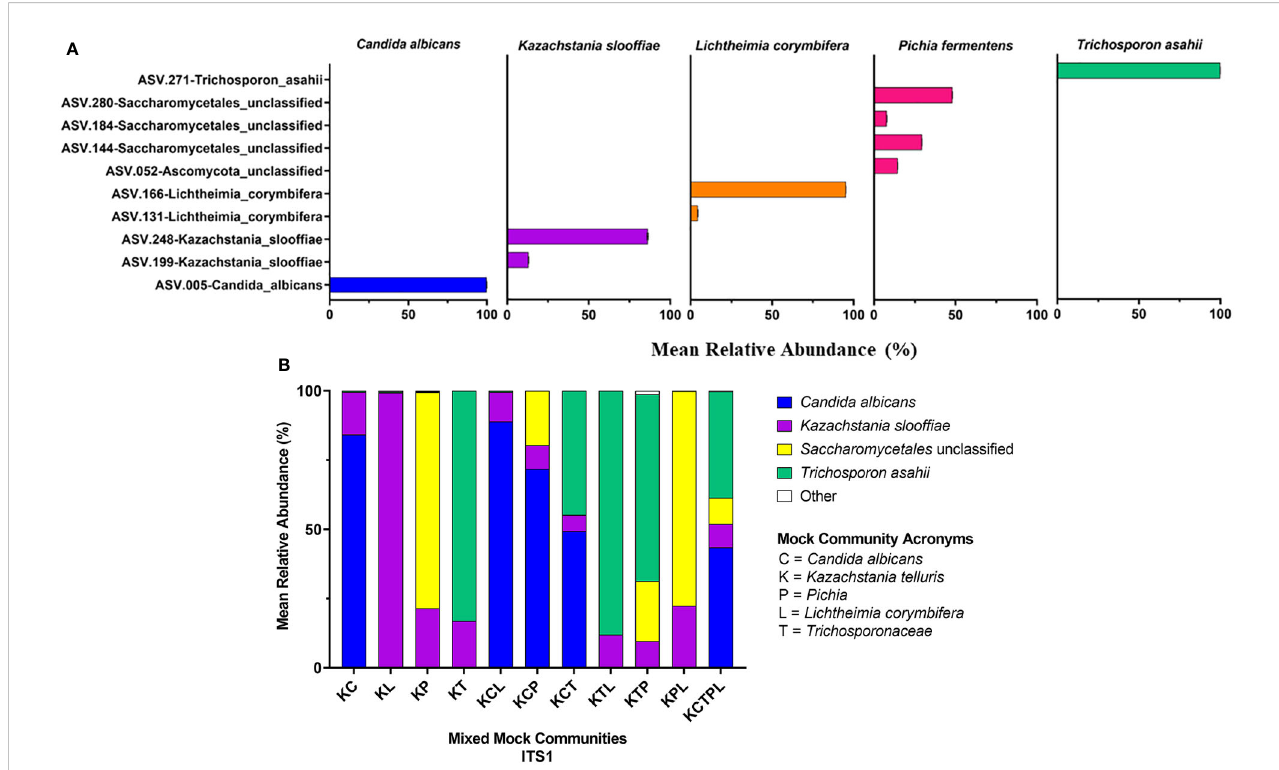
FIGURE 4 ITS2 Sequencing Results. ITS primers were used to sequence individual fungal isolates, C albicans, K sloof fi ae, L. corymbifera, P. fermentans , and T. asahii (A) or mock communities ranging from 2 isolate combinations up to all 5 in one mock community (B) . Each mock community is represented on the x axis with an acronym representing the fungi in the mock community. C, Candida albicans ; K, Kazachstania telluris ; P, Pichia ; L, Lichtheimia corymbifera , and T, Trichosporonaceae . Combinations are represented with the fi rst letter of each fungus found in each mock community, for example, KC, Kazachstania and Candida